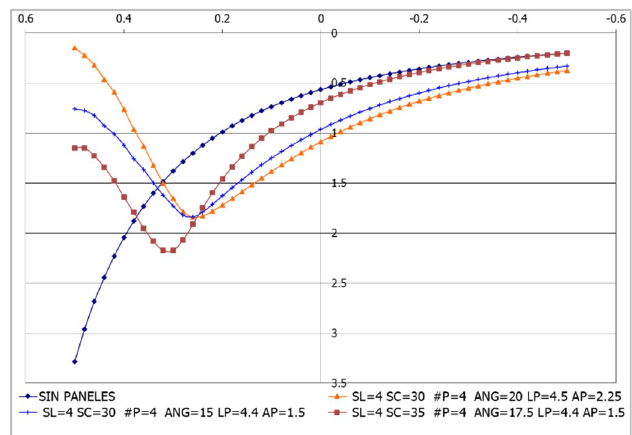
Figure 26. Ariari River, PR68: hydraulic modeling results with BVANE for different combinations of